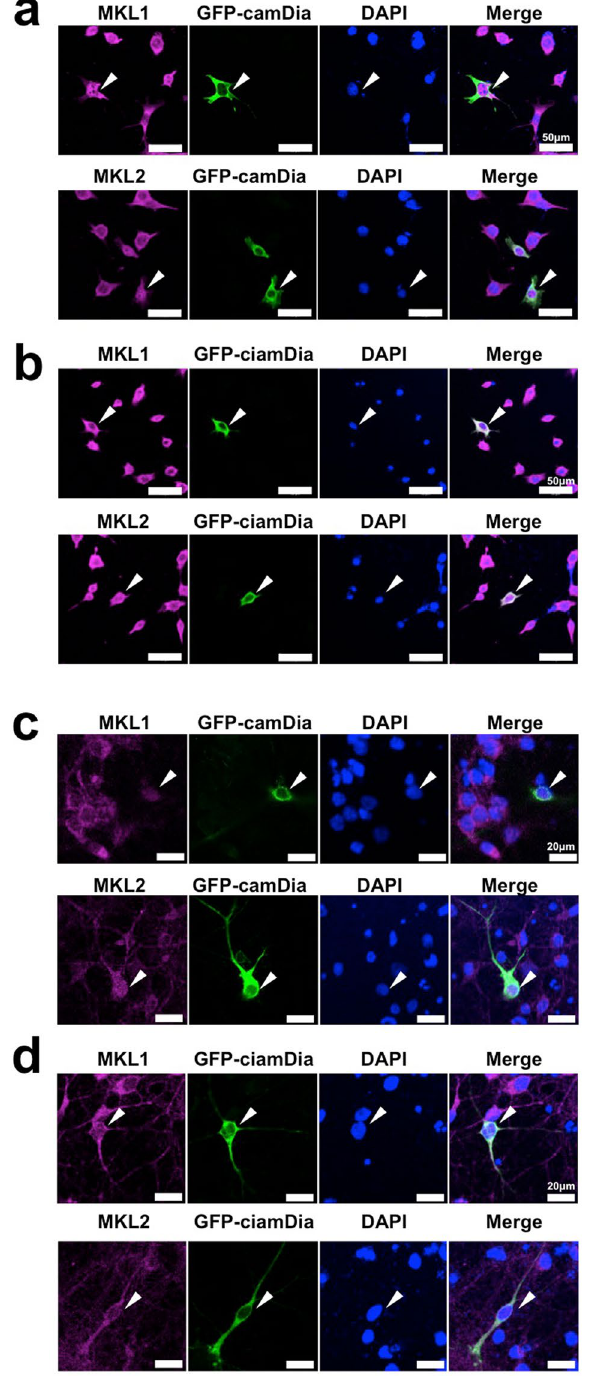
Figure 2. Nucleocytoplasmic staining of MKL in NIH3T3 cells and cortical neurons expressing a Rho effector, mDia. NIH3T3 cells were transfected with GFP-tagged constitutively active (ca) mDia ( a ) or constitutively inactive (cia) mDia ( b ). Twenty-four hours later, cells were immunostained with anti-GFP and anti-MKL1 or anti-MKL2 antibodies. Cortical neurons (7 days in culture) were transfected with camDia (4 μ g/well, c ) or ciamDia (4 μ g/well, d ). Twenty-four hours later, cells were immunostained with anti-GFP and anti-MKL1 or anti-MKL2 antibodies. Arrowheads indicate GFP-mDia-positive cells. Data regarding the cellular localisation of MKL are presented in Supplementary Figure